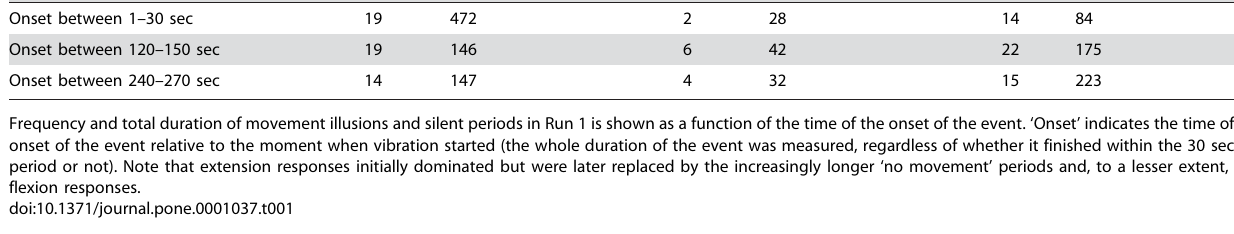
Table 1. Frequency and duration of movement illusions and silent periods .. ... .... ... ... .... ... ... .... ... ... .... ... ... .... ... ... .... ... ... .... ... ... .... ... ... .... ... ... .... ... ... .... ... ... .... ... ... .... ... ... .... ... ... .